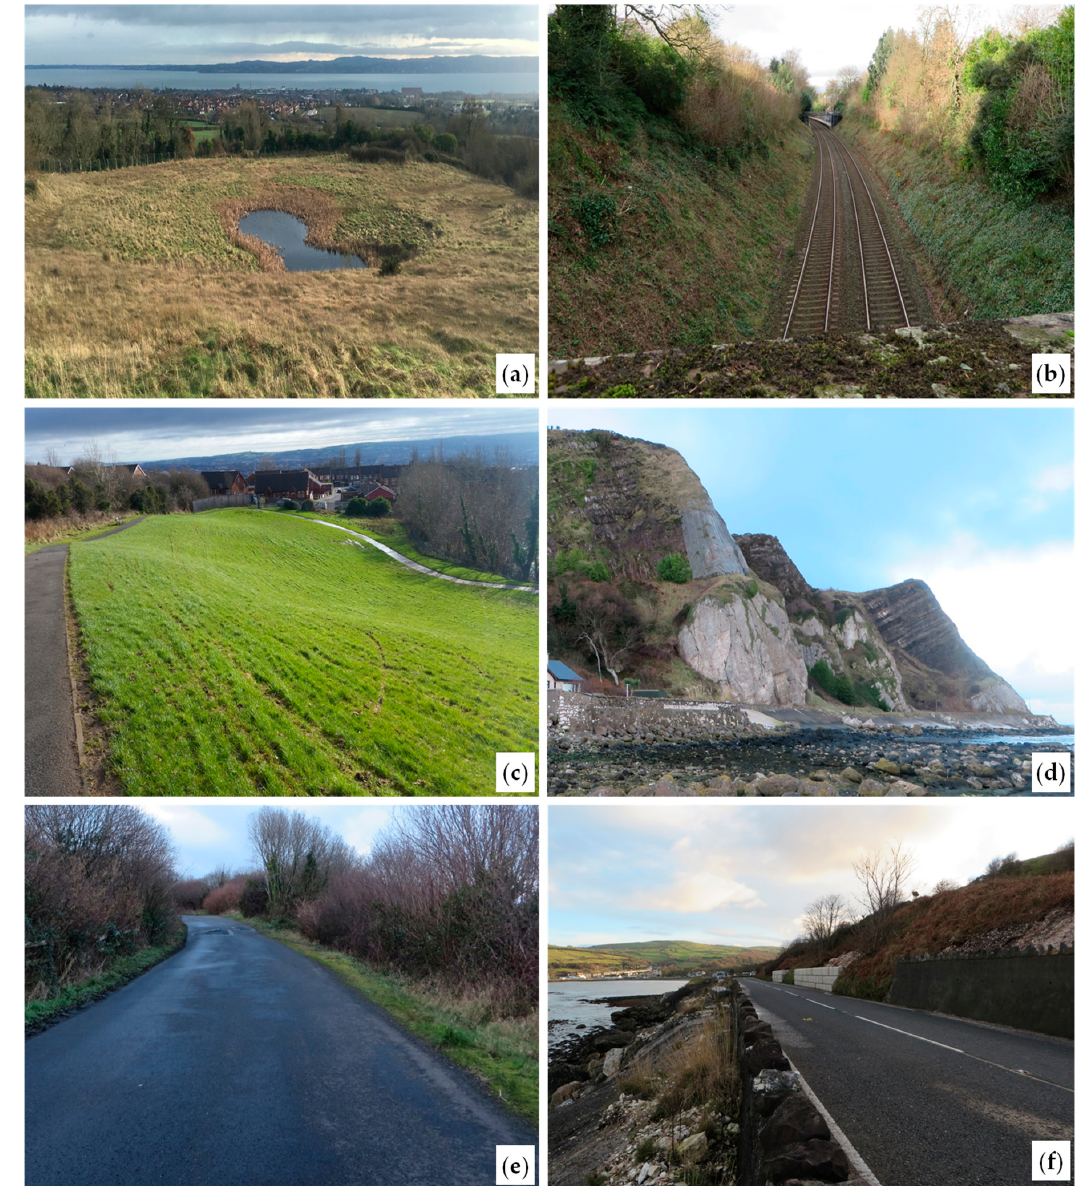
Figure 2. Photographs of the areas of interest taken on 9 February 2016: ( a ) Maiden Mount salt mine collapse, Carrickfergus; ( b ) Belfast–Bangor railway line; ( c ) Ligoniel Park; ( d ) Garron Point; ( e ) Straidkilly Road; and ( f ) stabilisation works along the Antrim Coast Road.